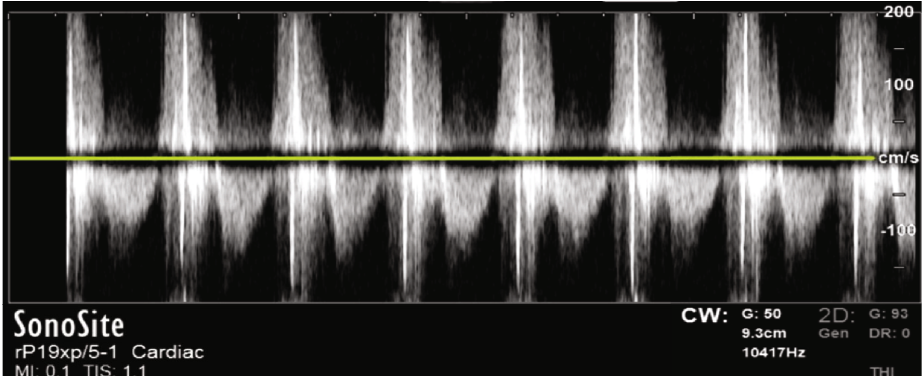
Figure 5: Velocity time integral (VTI) demonstrating aortic regurgitation. The negative de fl ections show the normal forward fl ow of blood through the aortic valve, but the presence of positive de fl ections show the regurgitant fl ow.